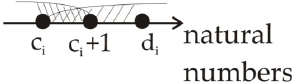
Figure 7. Possible values of Literal